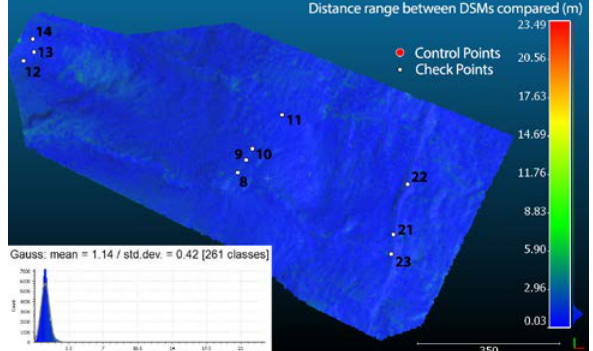
Figure 11. Scenario (e) Distance range comparison and Gauss curve fitting on distance difference histogram values (units in m) Min=0.03 / Max=3.50 / Mean=1.14 / Std. Dev.=0.42